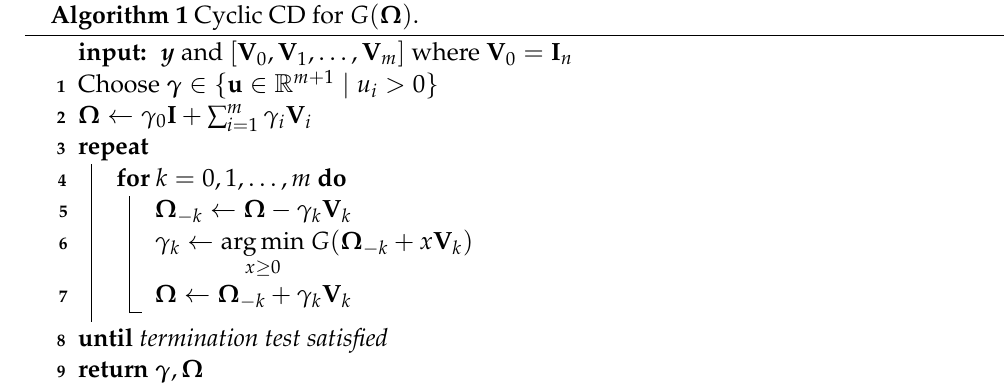
Algorithm 1 Cyclic CD for G ( Ω )